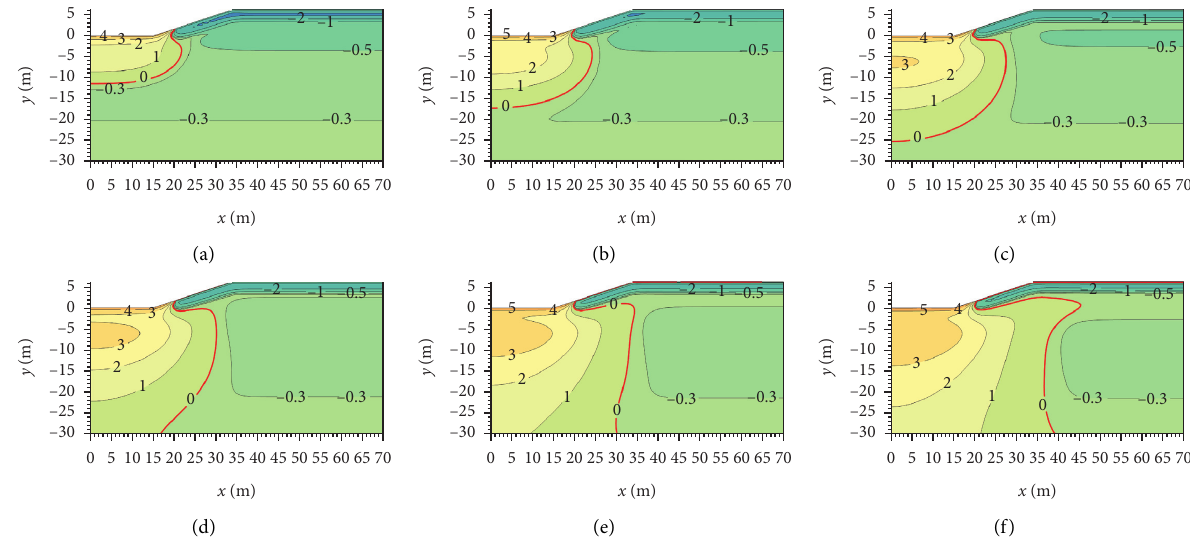
Figure 5: Thermal regimes of subgrade beneath the channel on April 15, after 5 (a), 10 (b), 20 (c), 30 (d), 40 (e), and 50 (f) years of the channel excavation (unit: °